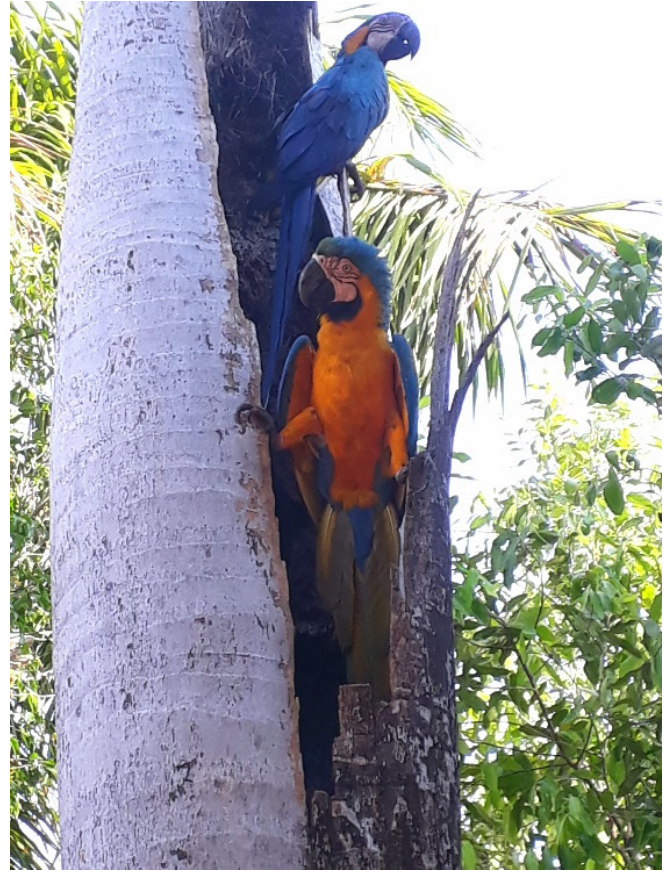
Figure 1. Blue-and-yellow macaws on a dead palm in a backyard in